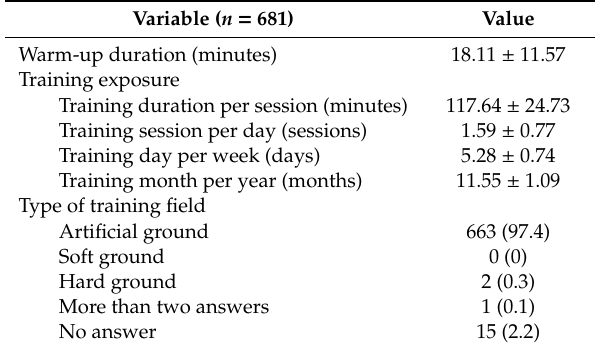
Table 2. Information about training conditions in U-15 youth soccer during the 2019 season.